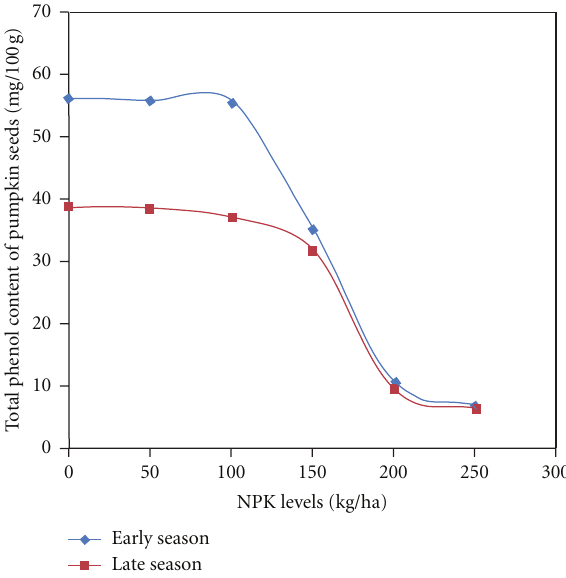
Figure 5: Total phenol and proanthocyanidin content of pumpkin seeds as a ff ected by season by NPK fertilizer.